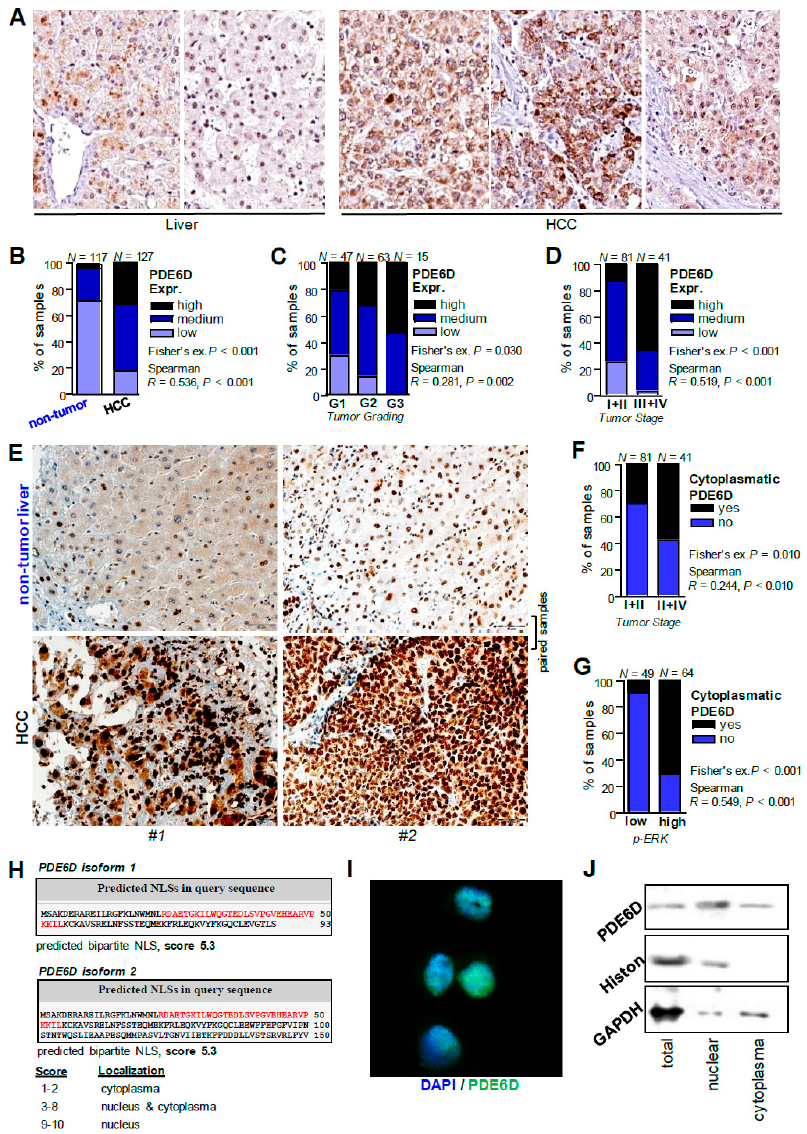
Figure 6. Expression and cellular localization of PDE6D in HCC in vivo and in vitro. ( A ) PDE6D staining (exemplary images) of non-tumorous liver tissues (left side) and HCC tissues (right side) deposited on the Human Protein Atlas database. ( B ) Tissue microarray analysis of PDE6D expression levels in human HCC tissues ( N = 117) as compared with corresponding non-tumorous liver tissues ( N = 127) (Fisher’s exact P < 0.001). ( C , D ) Tissue microarray analysis of PDE6D expression levels in human HCC tissues correlated with tumor grading (Fisher’s exact P = 0.030) ( C ) and tumor stages ( D ). ( E ) Exemplary immunohistological images of PDE6D protein expression in human HCC samples and corresponding non-tumorous liver tissues applying a tissue microarray revealing nuclear staining next to cytoplasmatic staining patterns (paired samples of two different patients (#1, #2) are depicted). ( F , G ) Tissue microarray analysis comparing tumor stages ( F ) and ERK activation (p-ERK) ( G ) in human HCC tissues with (“yes”) and without (“no”) cytoplasmatic localization pattern of PDE6D. ( H ) In silico-based analysis of importin- á -dependent nuclear localization signals (NLS, red letters ) using the “cNLS Mapper” predicted bipartite NLS in both isoforms of PDE6D (score for both isoforms was 5.3). A legend depicts that higher scores indicate stronger NLS activity and defines major localizations in dependence of each score. ( I , J ) Exemplary immunofluorescence ( I ) and Western blot analysis ( J ) depicting nuclear localization of PDE6D (I) and expression of PDE6D in both nuclear and cytoplasmatic fractions ( J ) of HCC cell